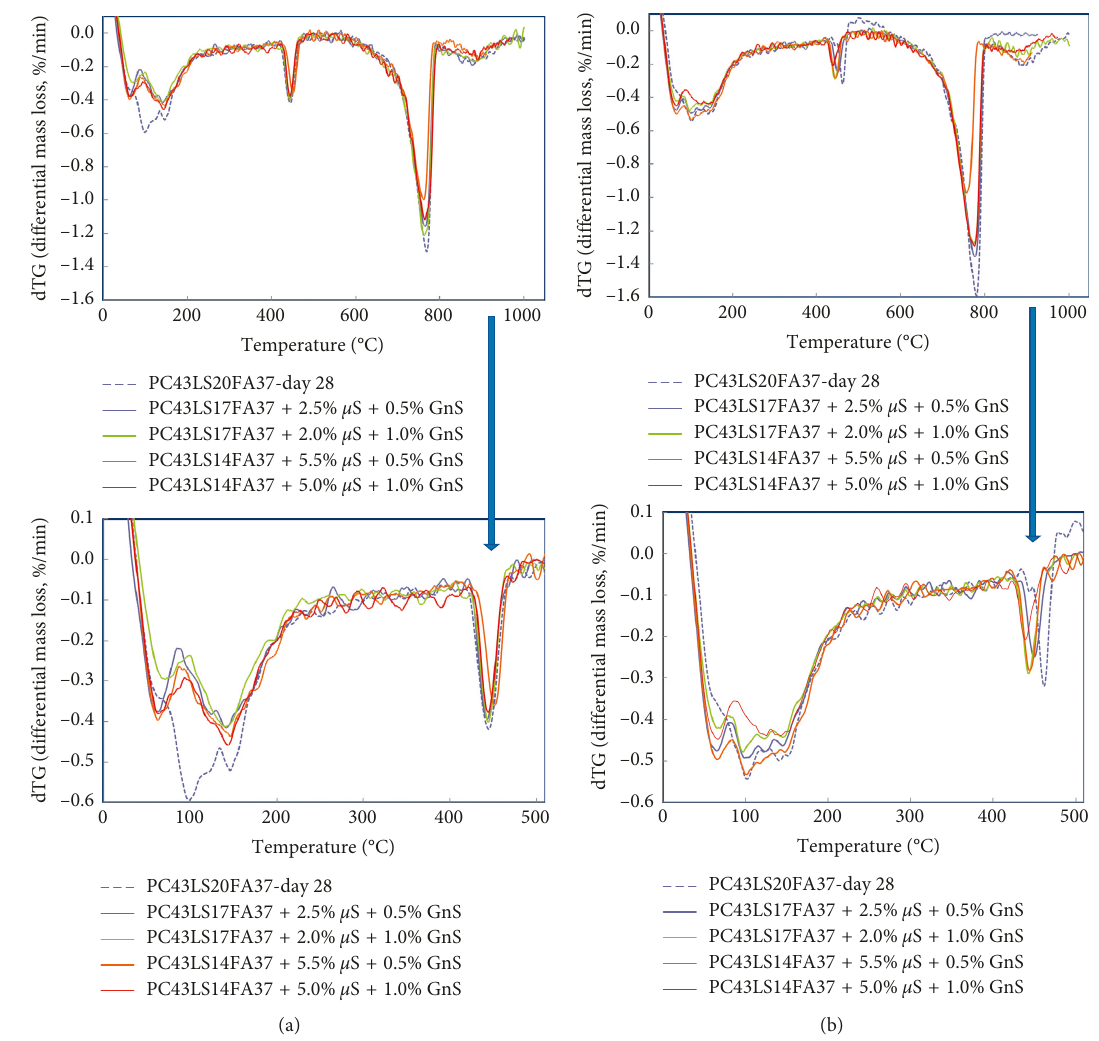
Figure 15: Differential mass loss of GnS and μ S nanocomposite binders based on PC43LS20FA37 between 0 and 1000 ° C at (a) day 28 and (b) day 56.